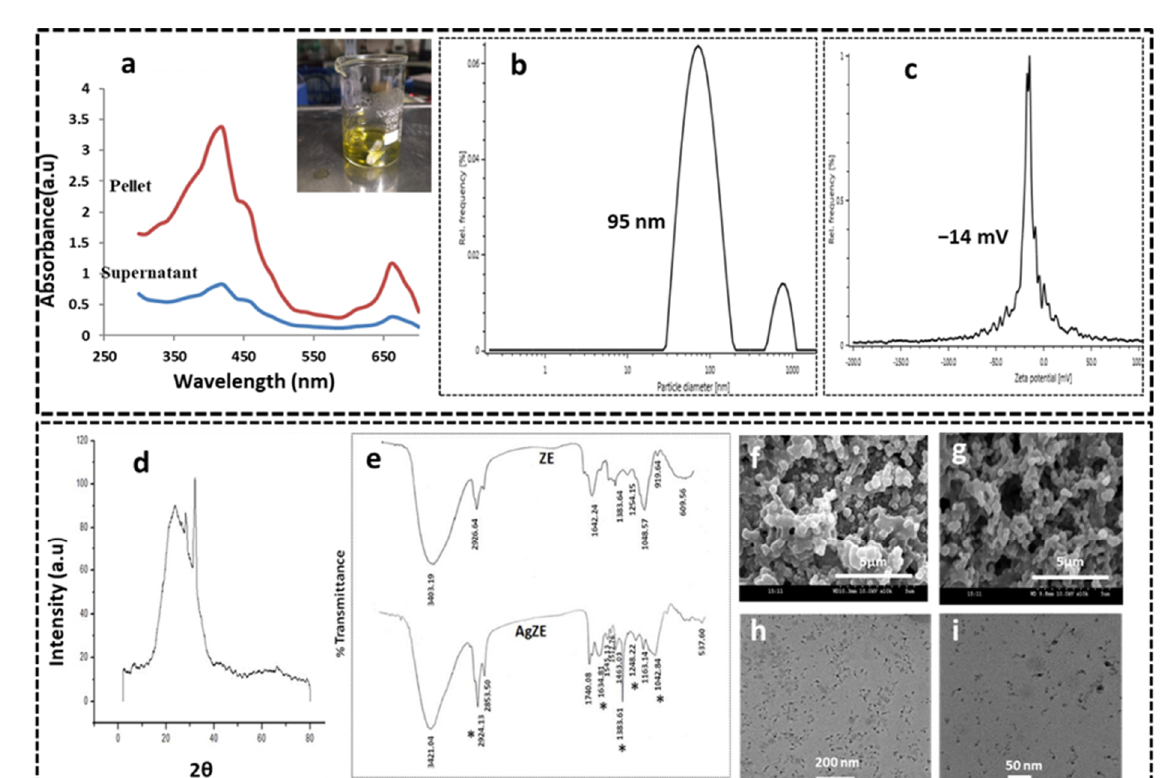
Figure 1. Characterizations ( a ) UV visible spectroscopy of the optimized pellet and the supernatant of AgZE; corner inset: representative image of the optimized AgZE reaction after 72 h indicating the formation of the silver nanoparticles, ( b ) hydrodynamic diameter (size) of AgZE, ( c ) charge (zeta potential) of AgZE, ( d ) XRD analysis of the AgZE showing its crystalline nature, ( e ) FTIR analysis of the ZE (top spectra) and AgZE (lower spectra) exhibiting the functional groups involved in nanoparticle synthesis, ( f , g ) SEM analysis of the AgZE showing its surface morphology (at magnification 5 µm for both images), and ( h , i ) TEM analysis of spherical shaped AgZE with minute tails. * indicates that functional groups observed in ZE extract are stretched in case of AgZE illustrating the involvement of active functional groups.